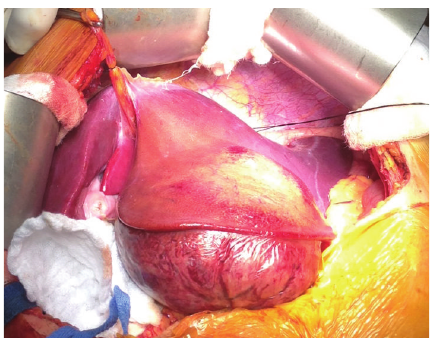
Figure 1: Surgical site showing tumor located in the left-lateral hepatic lobe next to grossly normal liver